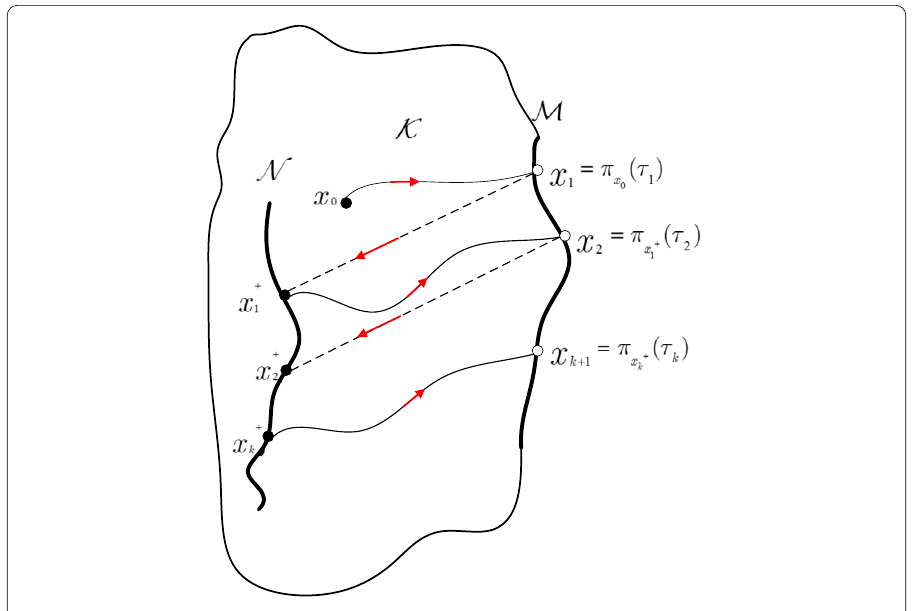
Figure 2 The trajectory (cid:17) π x